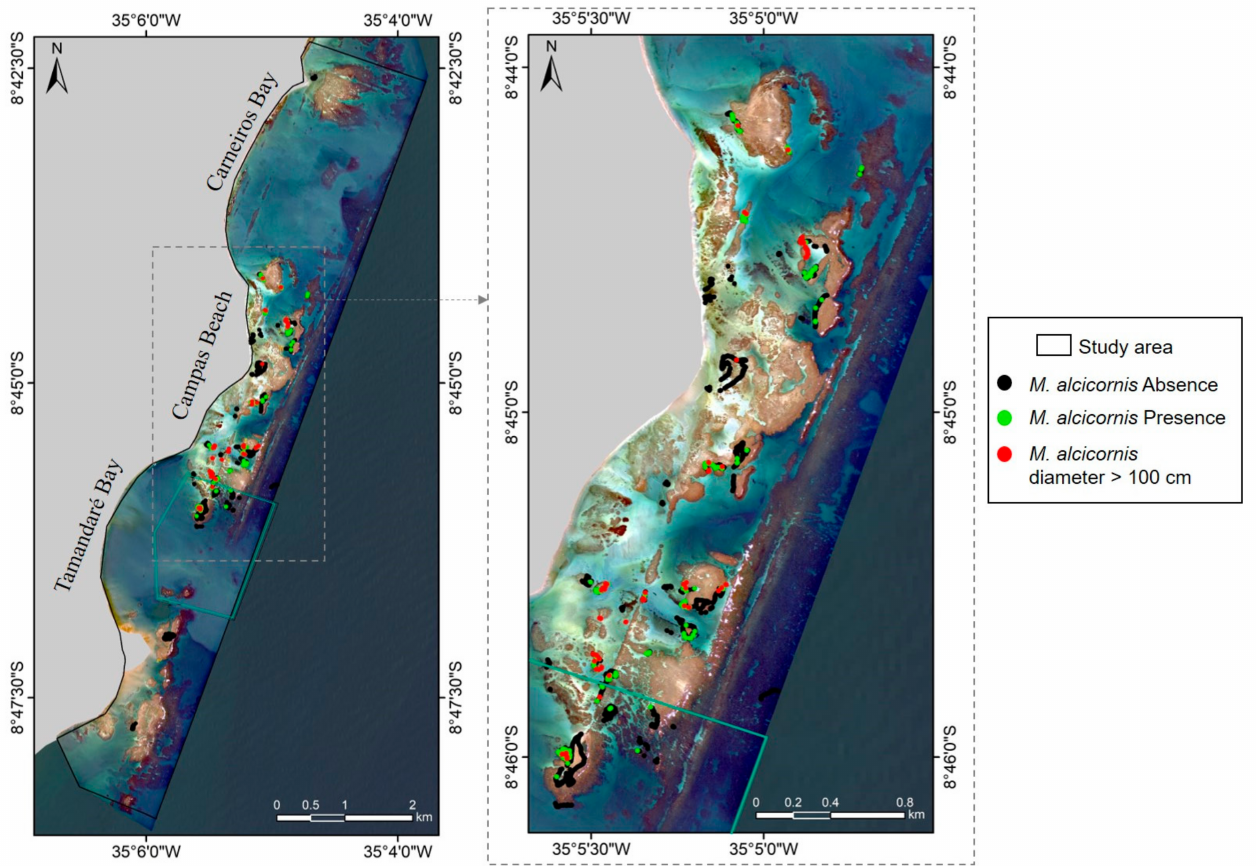
Figure 5. Millepora alcicornis presence data in Tamandar é , Brazil, used as input in MaxEnt modeling. Red dots show locations where large colonies of the species were found (222). Green dots show all Millepora alcicornis locations, considering smaller colonies (637). Black dots show all remaining field data (6578). Background satellite image: WorldView-03